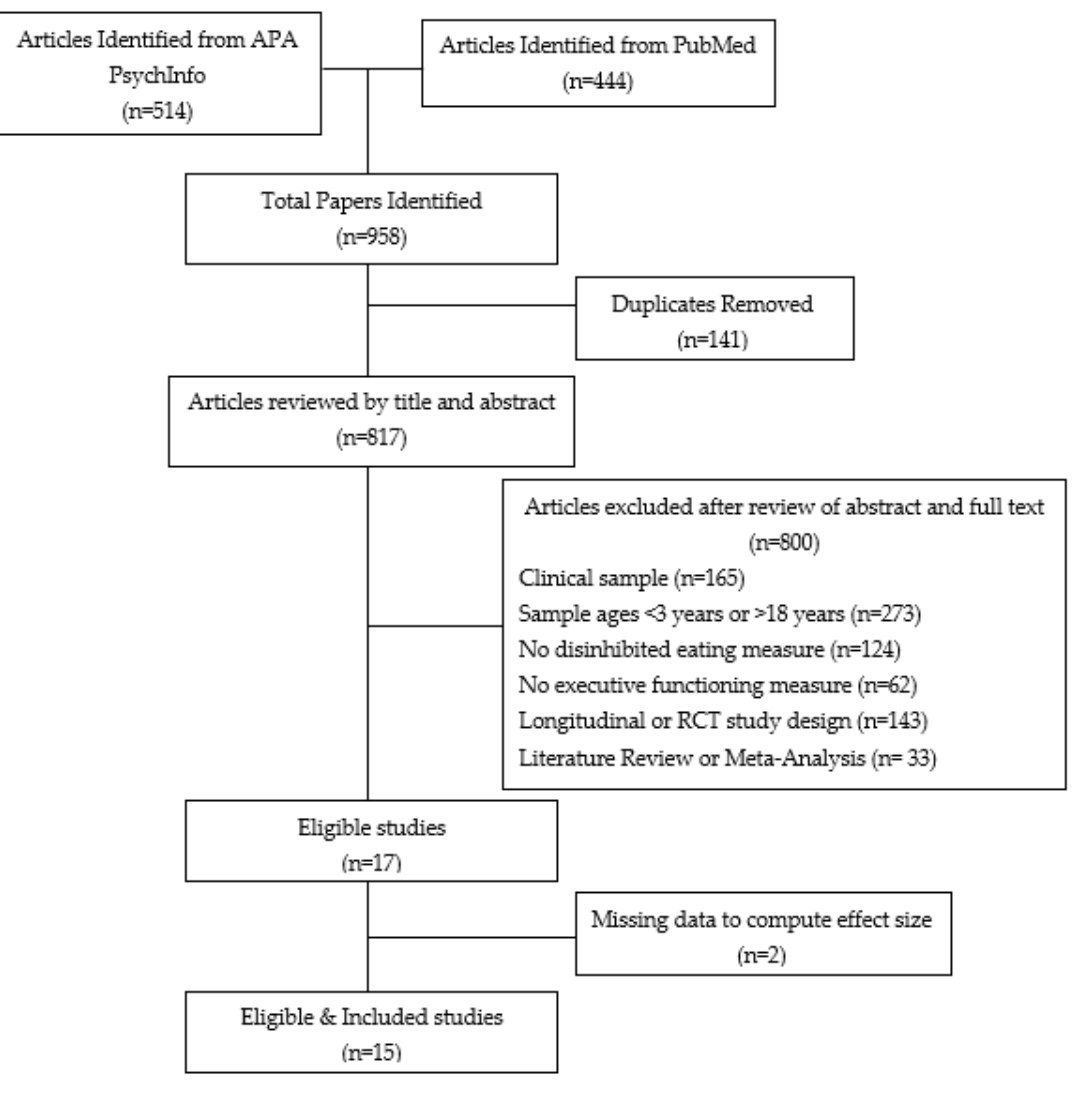
Table 1. Descriptive characteristics of included studies in the meta-analysis.